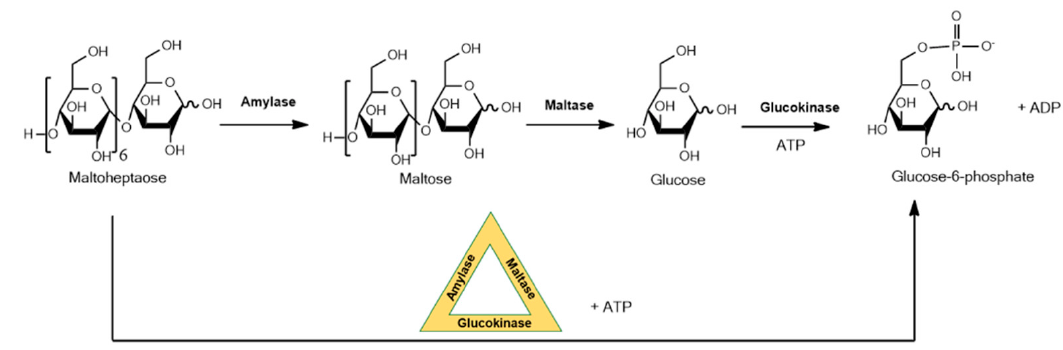
Figure 2. Three-enzyme sequential cascade using immobilized amylase, maltase and glucokinase on a self-assembled DNA origami triangle.